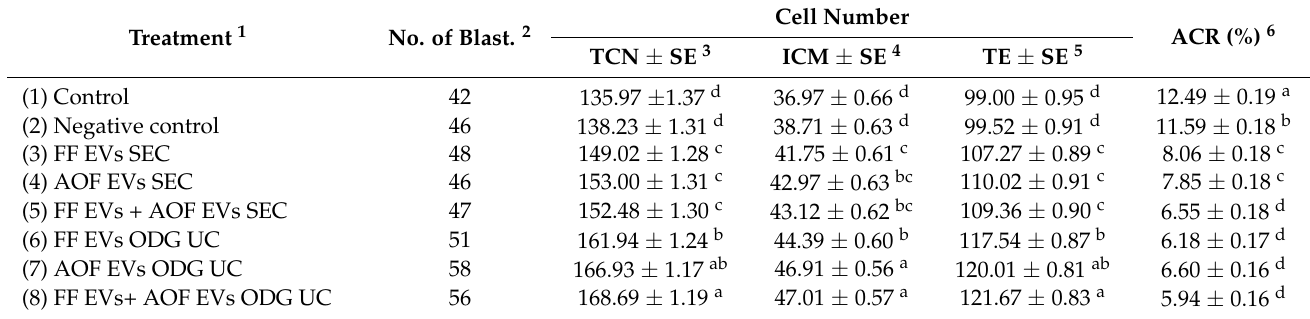
Table 3. Effects of the experimental treatments on the differential apoptotic cell (AC) count measures of day 8 blastocysts. Treatment 1 No. of Blast.